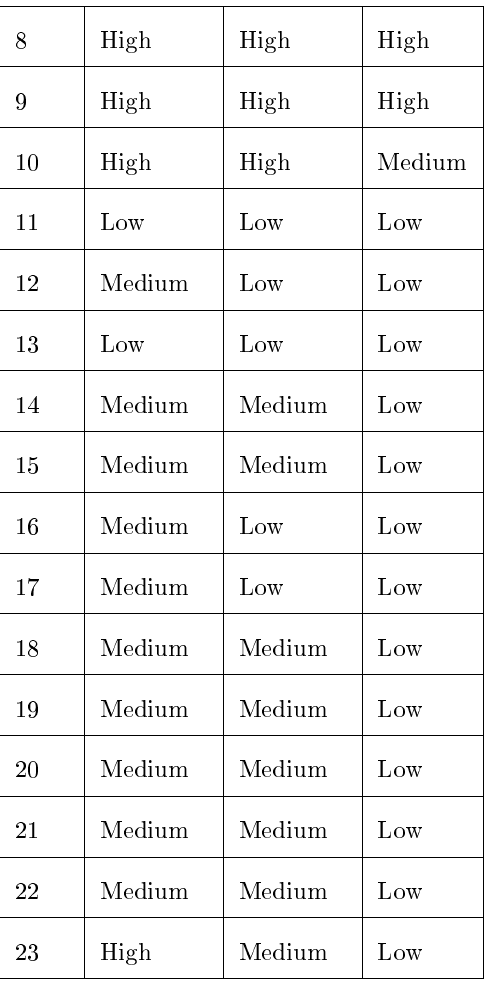
From Tab. 12, RPN indexes 1 and 2